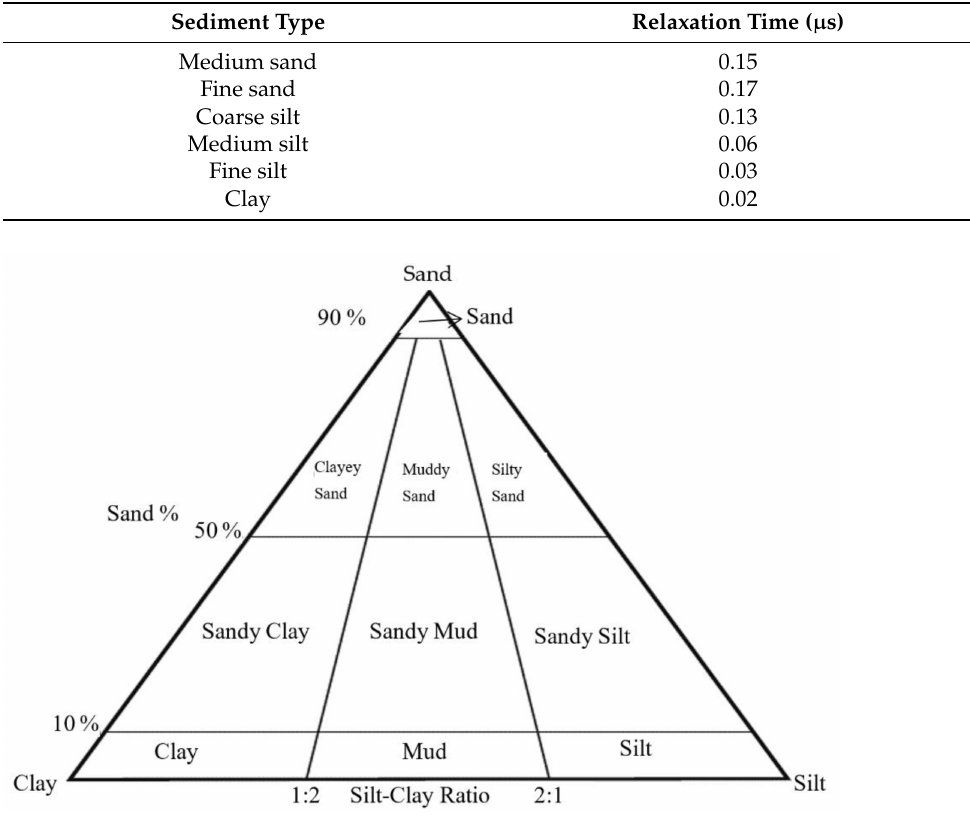
Figure 3. Illustration of the sediment nomenclature. Table 3. Relaxation time range for different sediment types after